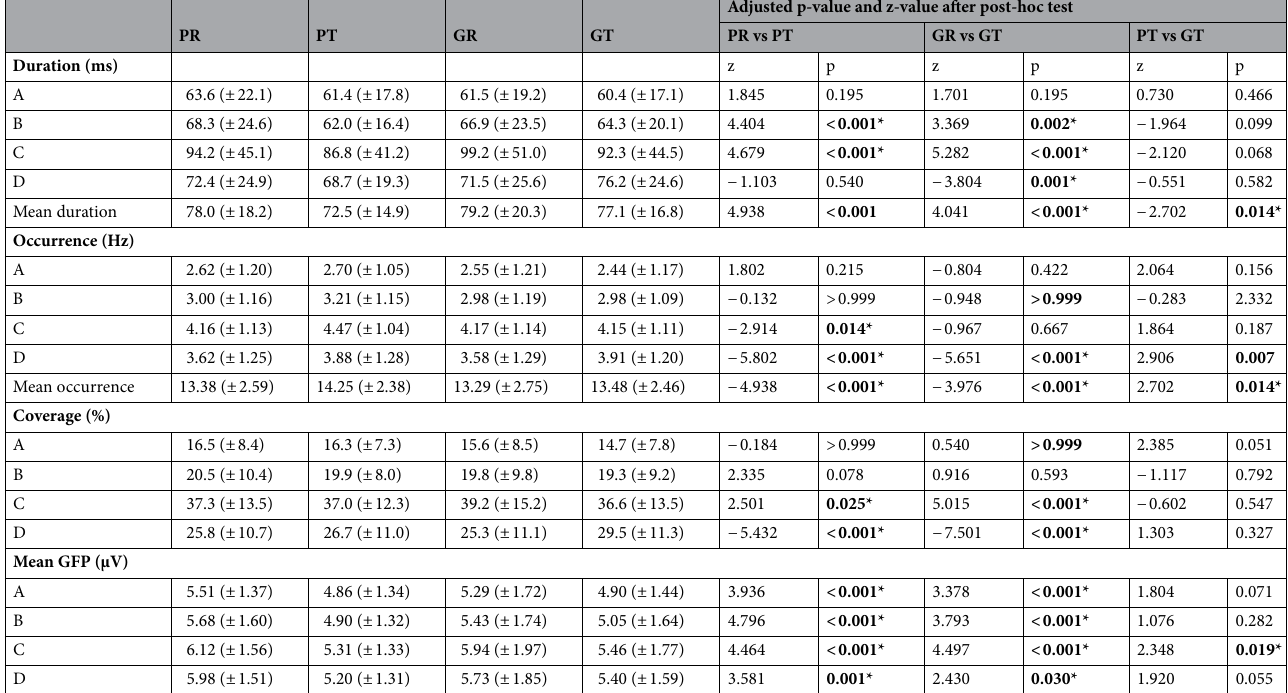
Table 1. Eighteen microstate features were obtained for the resting and task state EEG recordings in good performers and poor performers. Statistical analyses were performed using Mann–Whitney test. After Bonferroni–Holm correction for multiple comparisons, significant differences are indicated in asterisk and bold. PR poor performers in the resting state, PT poor performers in task state, GR good performers in resting state, GT good performers in task state, GFP global field potential, mean (± standard